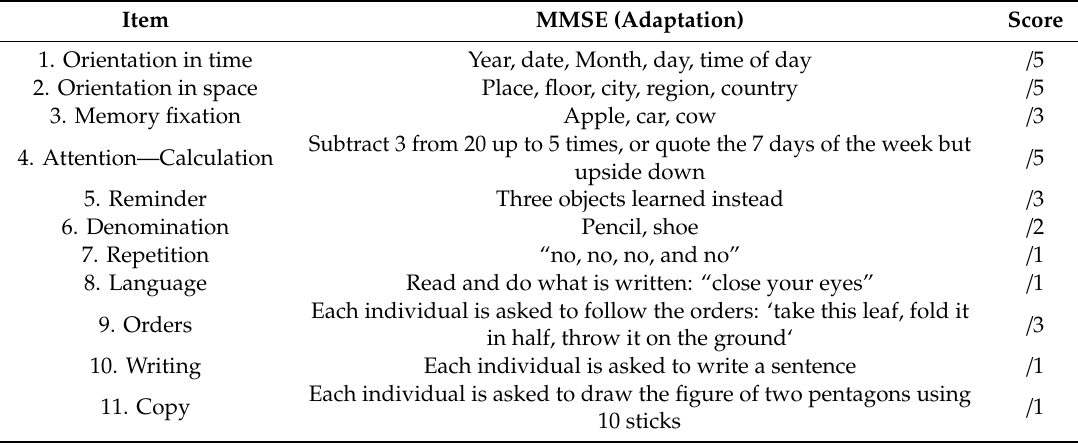
Table 1. Mini mental state examination (MMSE) with